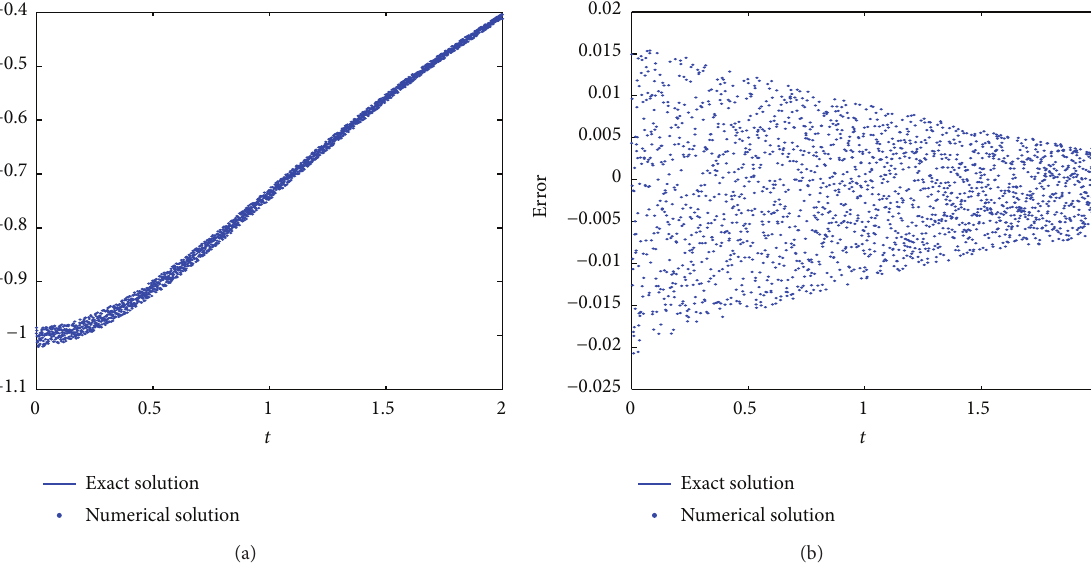
Figure 9: The exact solution 𝑓(𝑡) and the numerical solution of